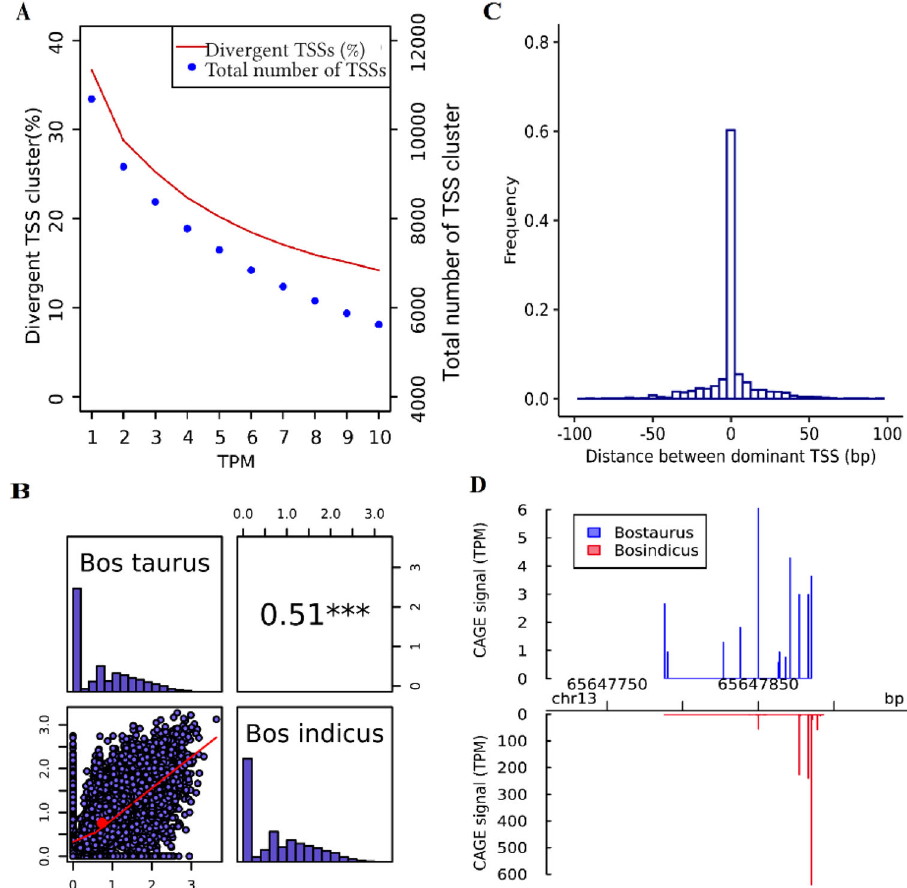
Fig. 2 Overview of comparison between Bos taurus and Bos indicus subspecies for adult liver. A Total number of TSS clusters and their percentage of divergent TSS at different expression levels (TPM), B Pearson correlation of TSS diversity measured by Shannon index (the distribution of Shannon index is shown on the diagonal and on the bottom of the diagonal the bivariate scatter plots with a fi tted line are displayed. Also, on the top of the diagonal, the value of the correlation plus the signi fi cance level ( P -value < 0.001) as stars is shown), C Histogram of distances between Bos taurus and Bos indicus dominant TSS in consensus TSS cluster with at least 10 TPM level expression, and D An example of differential TSS usage observed in gene MYL9 across two subspecies ( P -value and FDR < 0.05; shifting score = 0.21). The annotated TSS based on the Ref-Seq gene using Apr.2018 (ARS-UCD1.2/bosTau9)